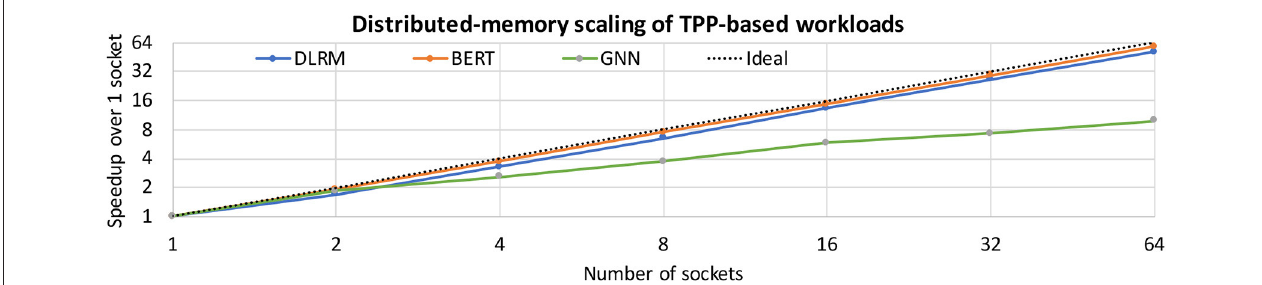
FIGURE 30 | Distributed-memory scaling of workloads.